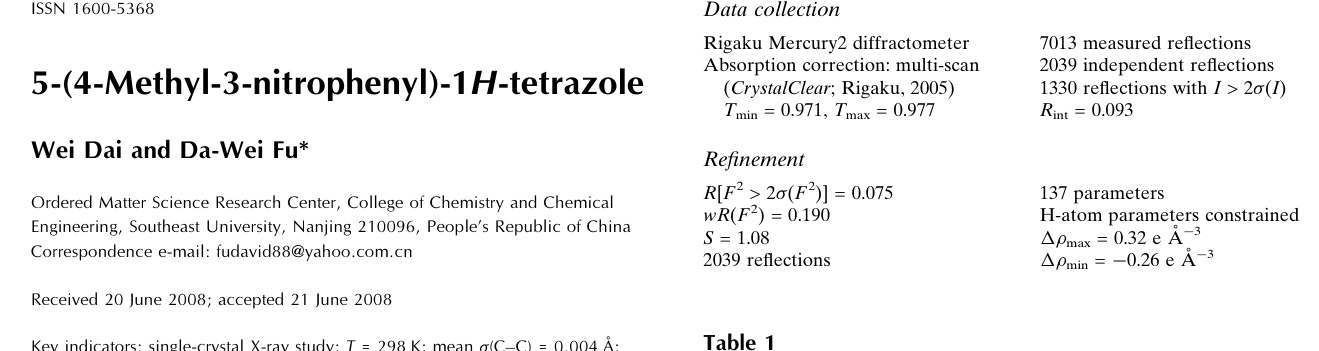
Hydrogen-bond geometry (A˚ , (cid:1)